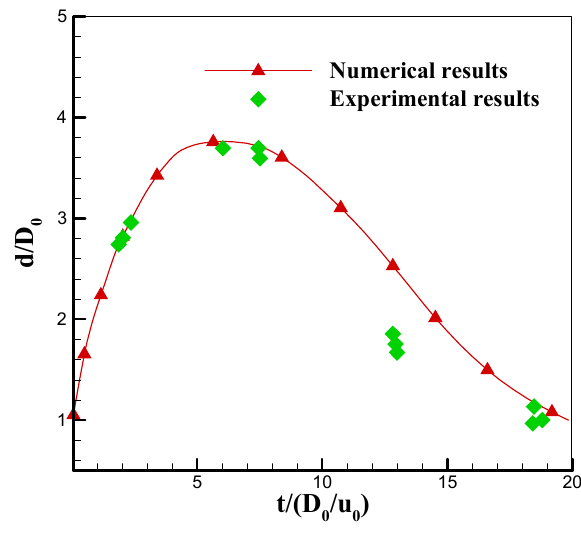
= 300 μ m, u = 5 0 0